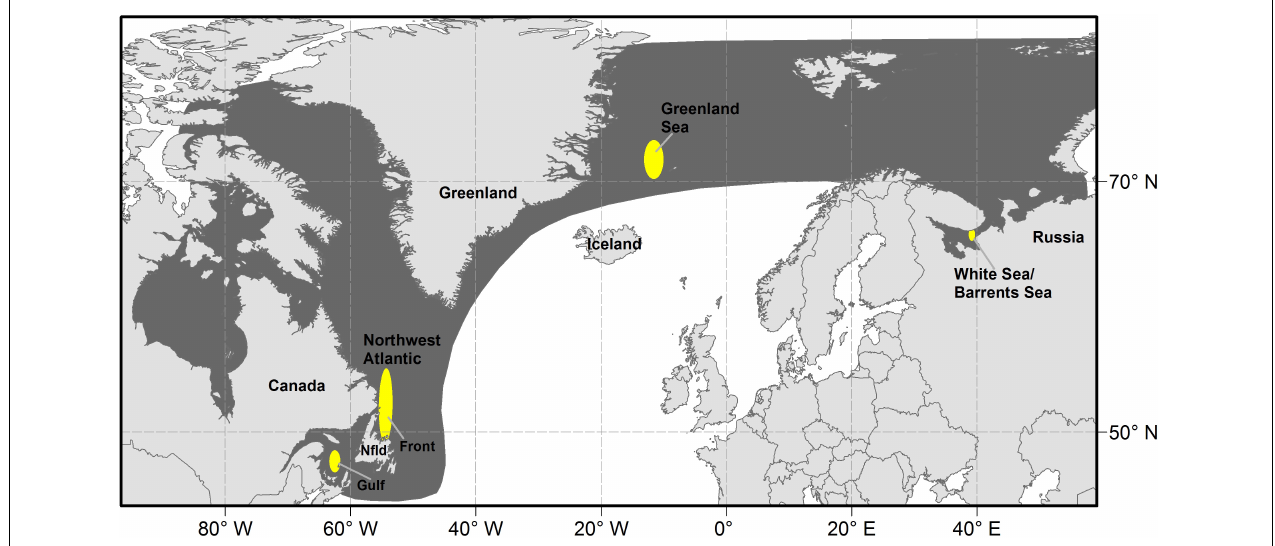
FIGURE 1 | Location of whelping concentrations (yellow) and range (dark shading) of harp seals in the north